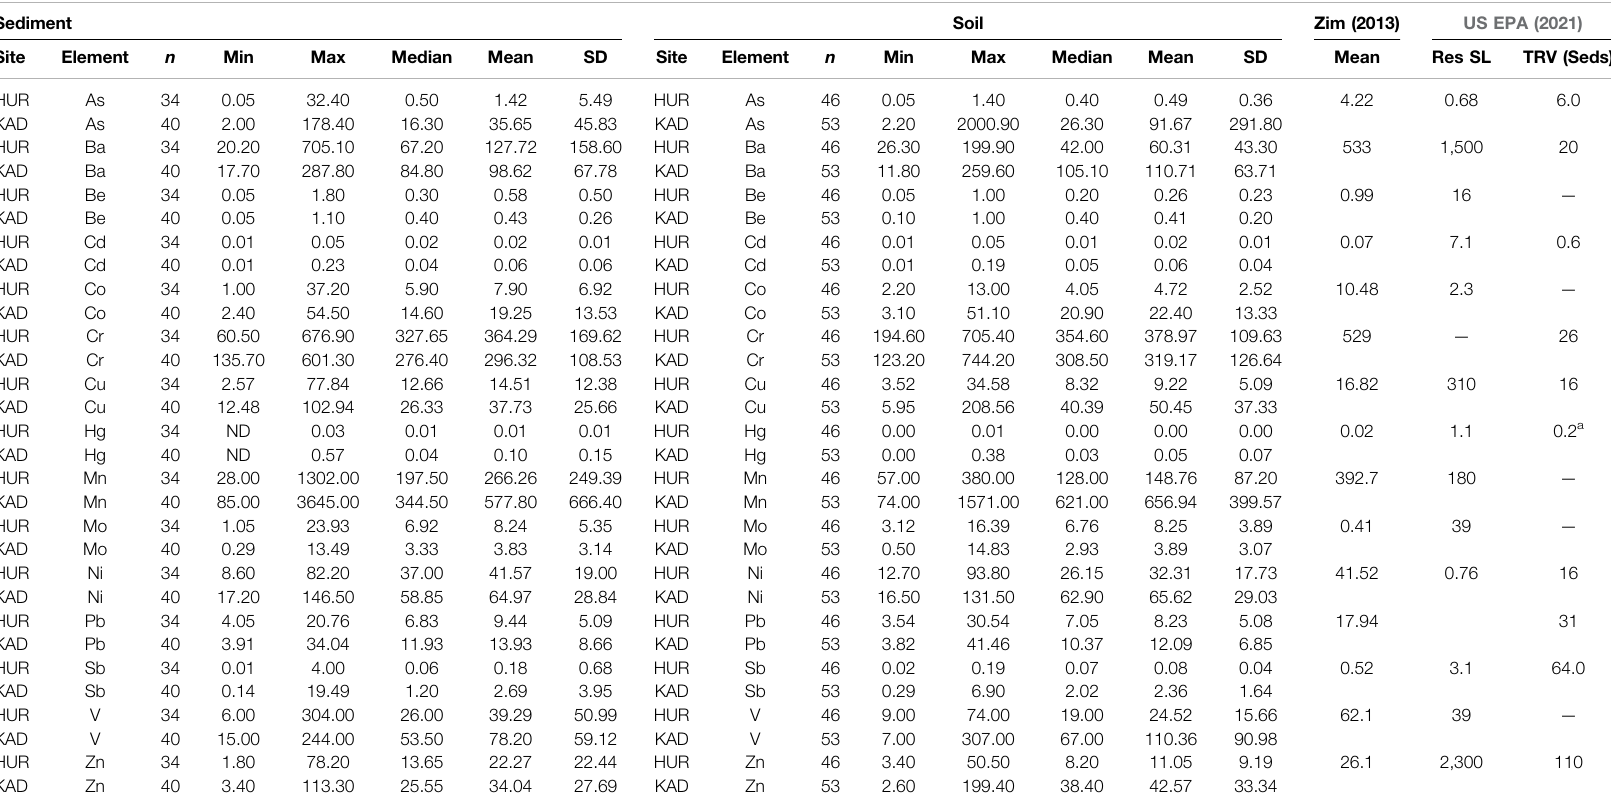
a Values used are for methyl mercury. ND = below the detection